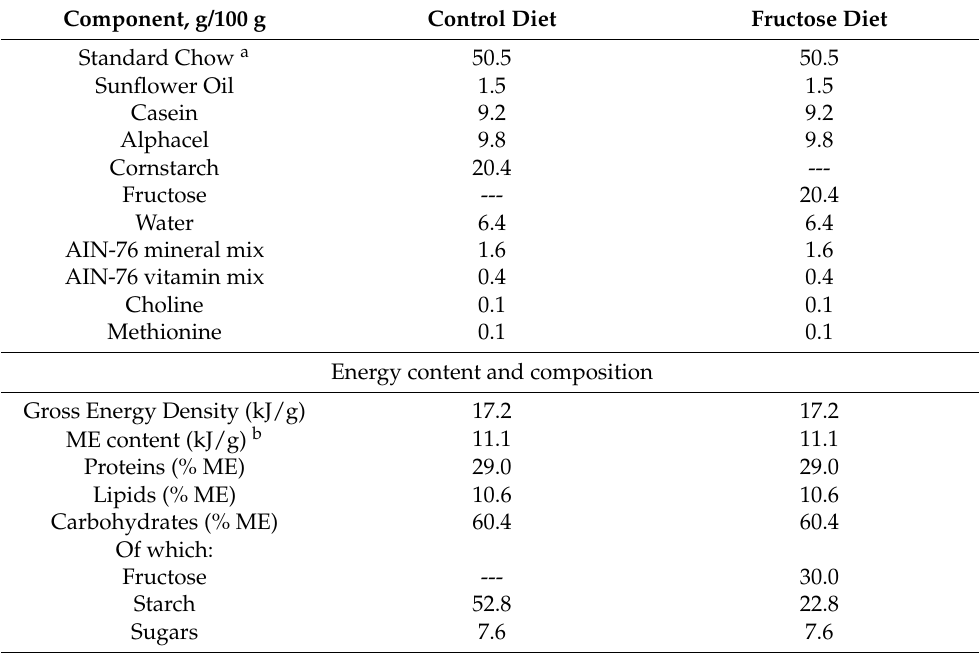
Table 1. Experimental diets